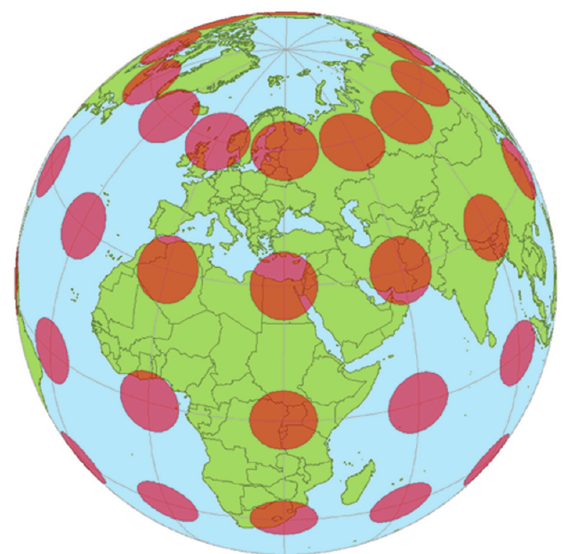
Fig. 11. The Tissot’s indicatrices based on a set of equally sized spherical circles